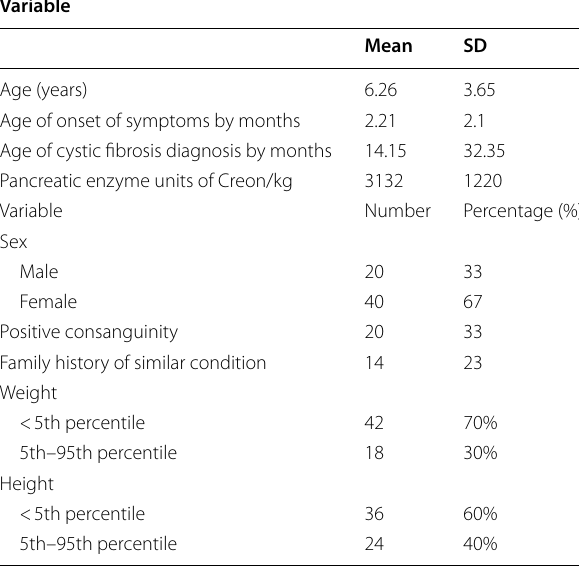
Table 1 Demographic data of the study